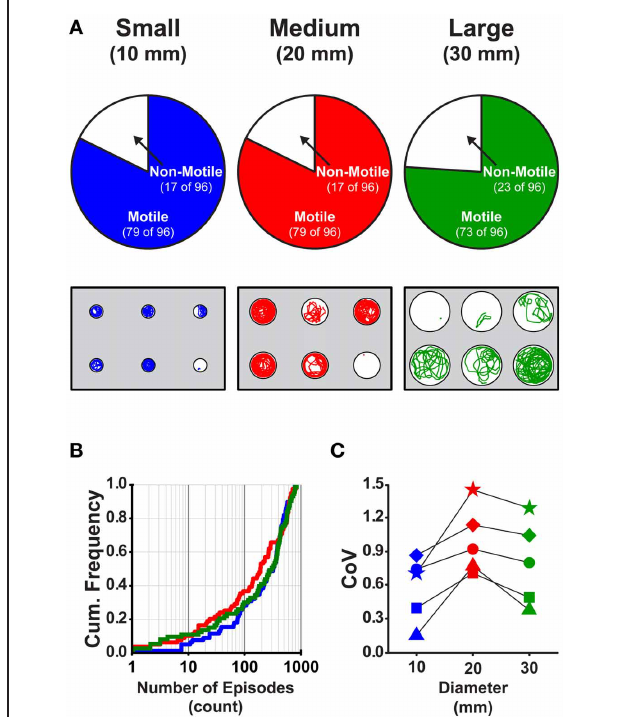
FIGURE 3 | The proportions of motile larvae are not different, but the variability among the locomotor properties is different for larvae in wells of different diameters. (A) Top Row , Pie charts depicting the proportions of motile and non-motile larvae in Small, Medium, and Large diameter wells (blue, red, and green, respectively). Bottom Row , Representative trajectory plots for larvae in 6-well behavioral arena plates (10, 20, and 30mm diameter wells shown); single larva per well. (B) Cumulative frequency plots for the number of swim episodes produced by larvae in Small, Medium, and Large diameter wells (blue, red, and green, respectively). (C) Plots of the group coefficients of variation (CoV) for all measured locomotor properties in Small ( n = 79), Medium ( n = 79), and Large ( n = 73) diameter wells (blue, red, and green, respectively). Symbols are: circle, episode frequency; square, episode duration; triangle, swim speed; diamond, active swim time; star, total distance.